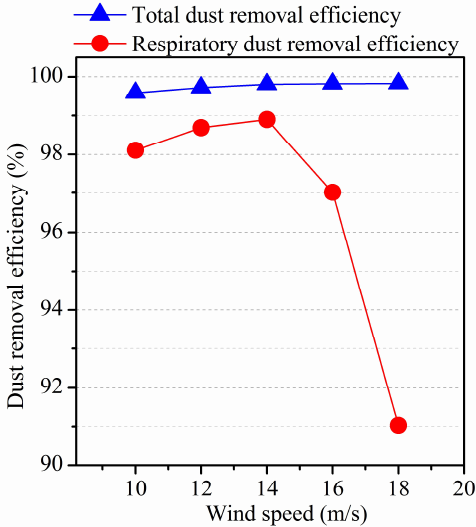
Figure 12. Relationship between wind speed and dust removal efficiency.